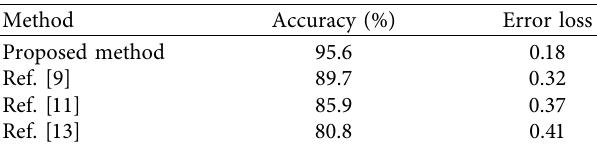
Table 1: Accuracy and error value of different fault diagnosis methods.